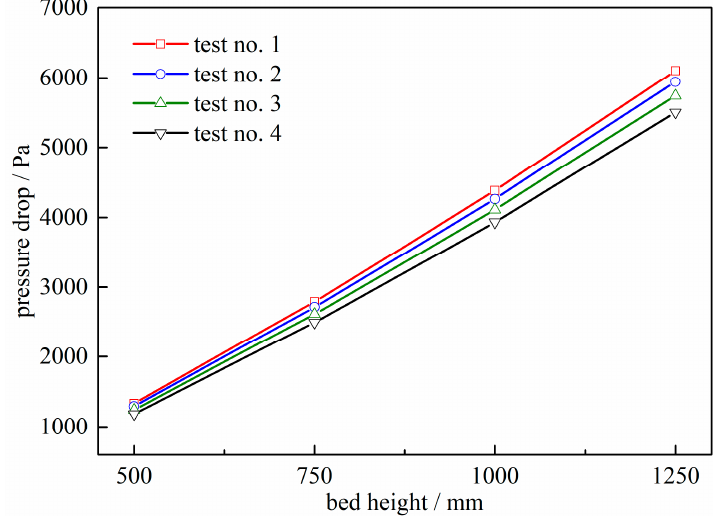
Figure 8. Relationship between pressure drop and bed height. Test no. refers to that listed in Table 2.